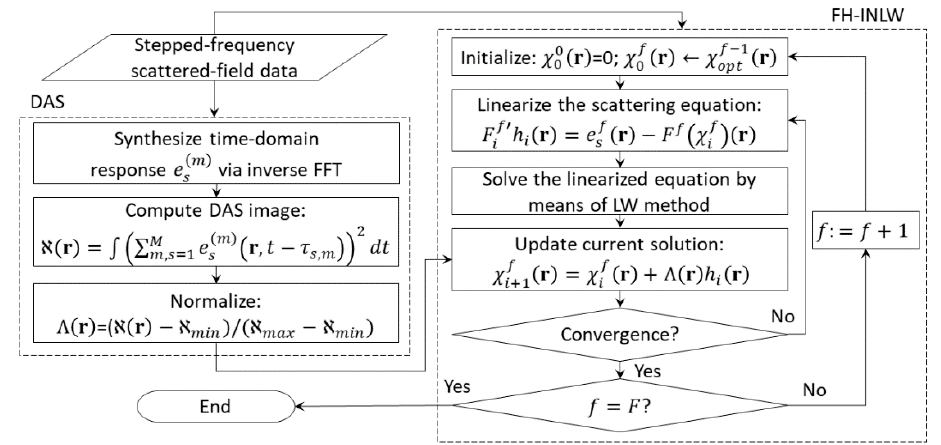
Figure 4. Flow chart of the inversion algorithm. DAS—delay-and-sum; FH-INLW—frequency-hopping inexact-Newton/Landweber.